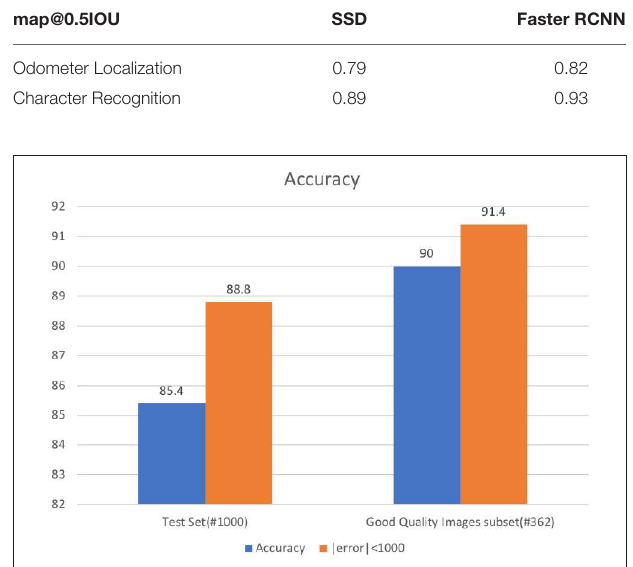
FIGURE 7 | Accuracy results